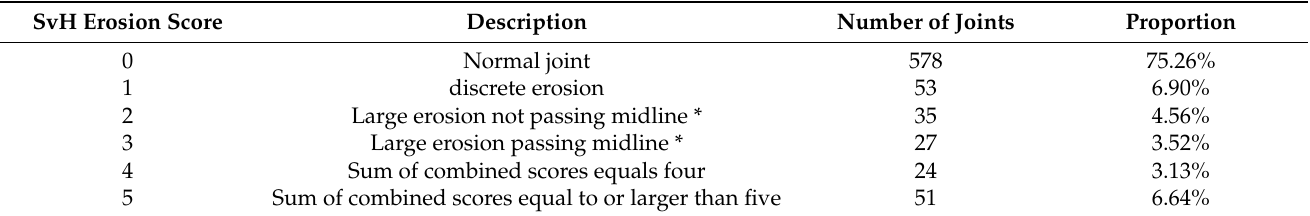
Table 3. Overview of the distribution of the disease stages according to the SvH erosion classification based on the 24 patients and 768 joints in the test data set [24].